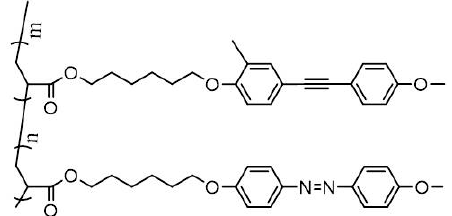
Figure 11. Schematic molecular structure of the P6Az–tolane copolymer.